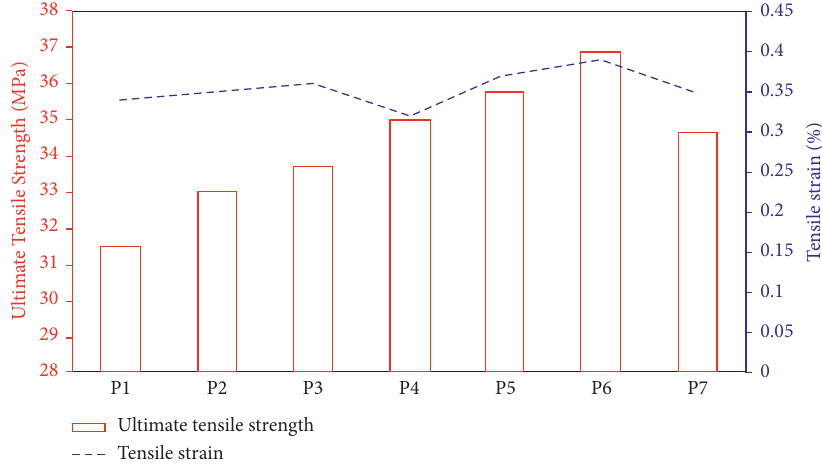
Figure 9: Ultimate tensile strength and strain analysis of composites.